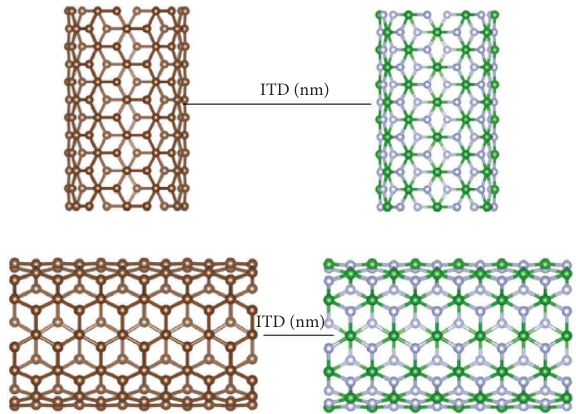
Figure 1: Carbon boron nitride nanotubes showing intertube distance